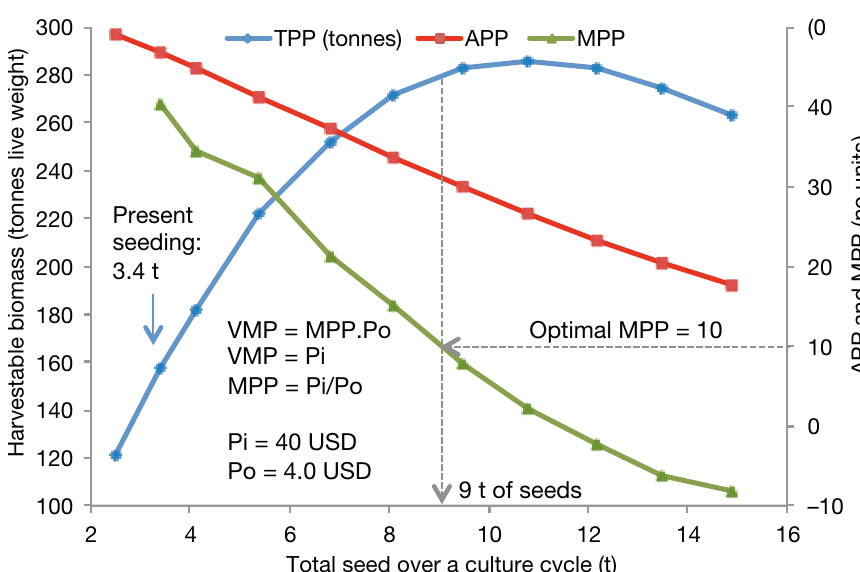
Fig. 11. Marginal analysis for Manila clam culture at Chuckanut Shellfish farm. APP: average physical product; MPP: marginal physical product; TPP: total physical product: VMP: value of marginal product; P i ( P o ): input